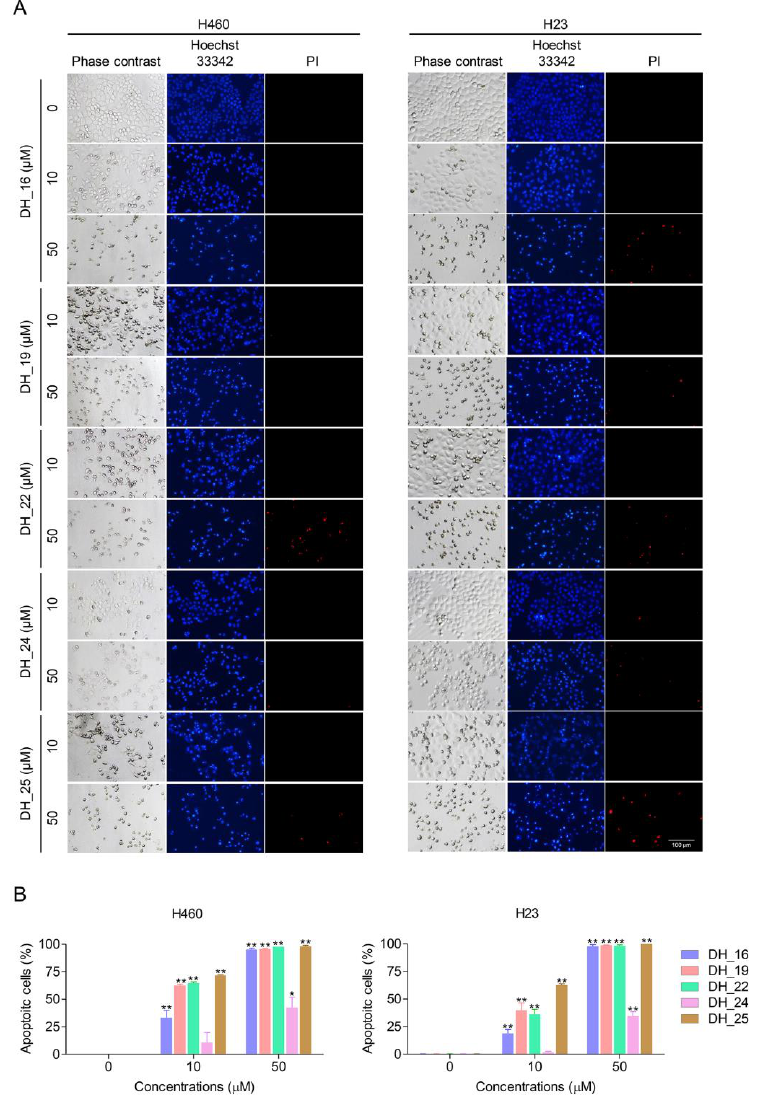
Figure 2. Derivatives of the RT right-half analog (DH_16, DH_19, DH_22, DH_24, and DH_25) induce apoptotic morphological changes in NSCLC cells (H460 and H23). ( A , B ) NSCLC cells were seeded and treated with 0 – 50 µM of DH_16, DH_19, DH_22, DH_24, and DH_25 for 24 h. Hoechst 33342 and PI were used to stain the cell nuclei. Images were obtained under a fluorescence microscope, and the percentages of apoptotic cells were calculated. Data are presented as the mean ± SD ( n = 3) (* 0.01 ≤ p < 0.05, ** p < 0.01, compared with the untreated control).